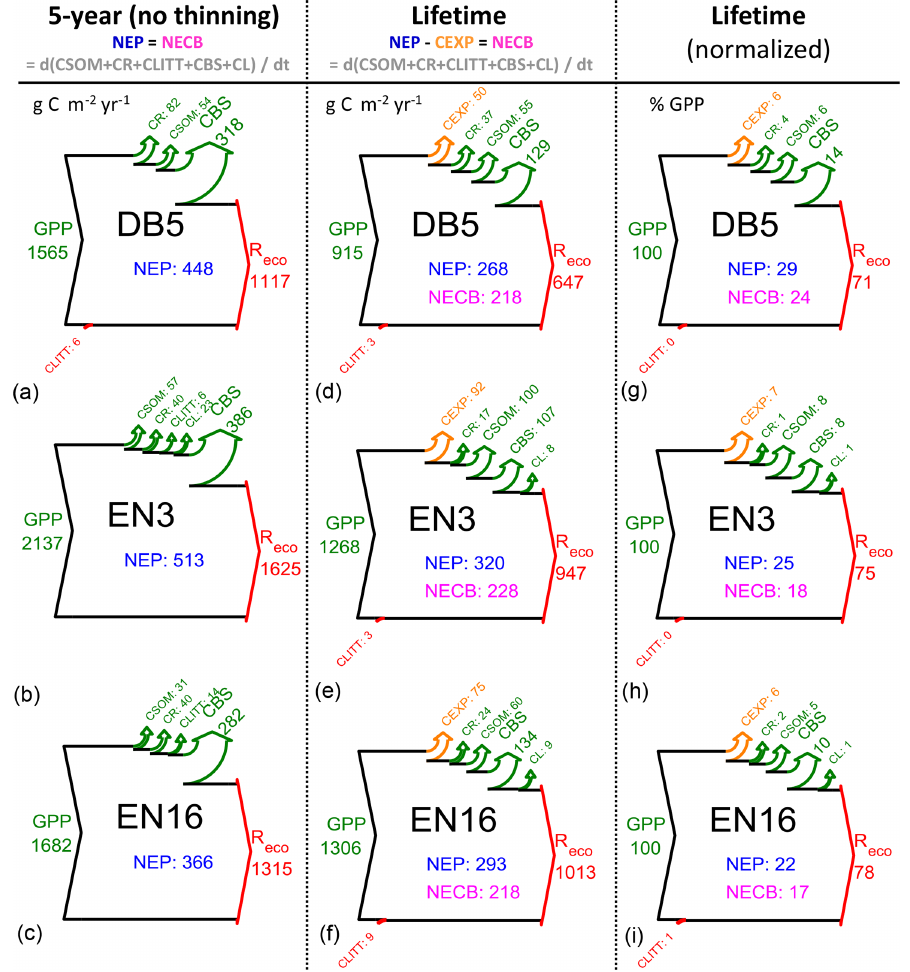
Figure 2. Modelled (BASFOR) budgets and partitioning of gross primary productivity (GPP), ecosystem respiration ( R eco ), net ecosystem productivity (NEP) and net ecosystem carbon balance (NECB) at three example forest sites (DB5: 45-year-old Fagus sylvatica ; EN3: 120- year-old Picea abies ; EN16: 51-year-old Pseudotsuga menziesii ), and associated modelled changes in C pools in soil organic matter (CSOM), roots (CR), litter layers (CLITT), branches and stems (CBS), and leaves (CL) (units: gCm − 2 yr − 1 , a – f ; normalized to % lifetime GPP in g – i ). Simulations were run either over the most recent 5-year period which did not include any thinning event (“5-year” in the text) or over the whole time period since the forest was established (“lifetime”). Green indicates ecosystem C gain (photosynthesis and C pool increase); red denotes ecosystem C loss (respiration and C pool decrease); the orange arrows indicate C export through thinning (CEXP). The NECB percentage value (g–i) corresponds to the lifetime carbon sequestration efficiency. The sizes of the Sankey plots are not proportional to the C fluxes of the different study